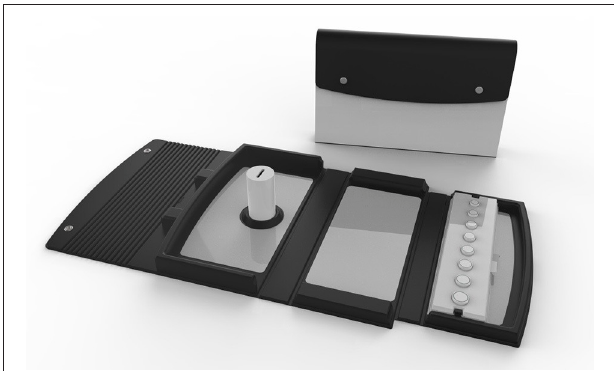
FIGURE 4 | The Clinch Token Transfer Test (C3t) is an optimized version of the Moneybox test (MBT). In preparation for dissemination and use in clinical trials, the C3t was developed so test components are made of robust materials that can be cleaned. It is also compact, with all test components contained within the case. The test procedure is more efficient, with token trays prepared and stacked ready for use so there is no set up time for the researcher between assessment items. Although the C3t procedure is ultimately the same as the MBT, unlike the MBT, the Dual Transfer task consists of tokens with different values to those in the Complex Transfer, which was added to reduce potential practice effects. Therefore, in the C3t, an additional value baseline item was added (Complex Value baseline), which proceeds the original Simple Value